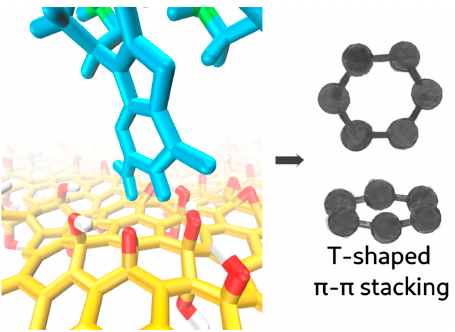
Figure 4. T-shaped π – π stacking shown as a simulation snapshot (left) and as a schematic (right). During a typical MD timeline, starting from the ssDNA backbone axis parallel to the GO surface plane (Figure 5), one or both ssDNA chain ends approached the graphene surface. Given a